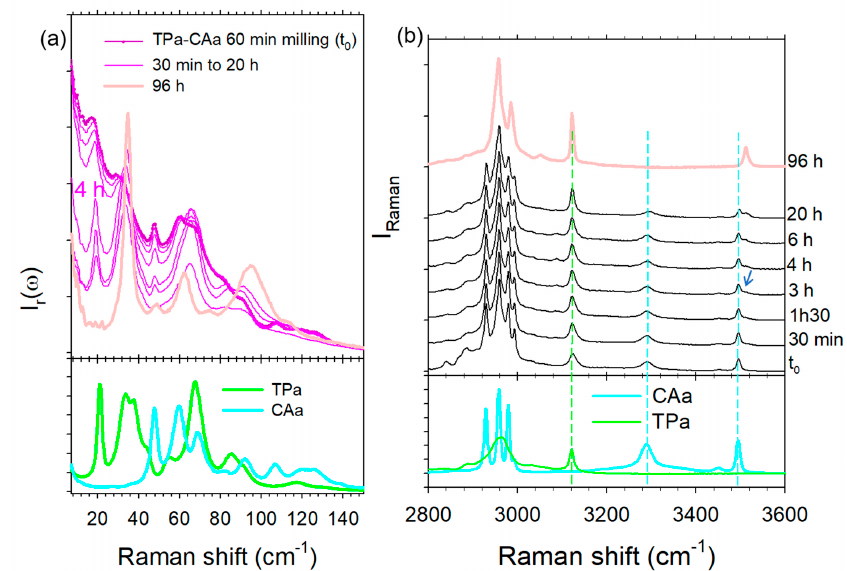
Figure 9. Spectra of (TPa, CAa) mixture co-milled at room temperature for 1 h, collected at various times after the milling procedure; ( a ) in the low-frequency region; ( b ) in the high-frequency region; spectra are compared with those of the anhydrous reactants (bottom graph); spectra were taken and plotted at same times in the low- and high-frequency regions . Raman investigations were simultaneously carried out in the high frequency region to better understand the mechanism of co-crystal formation. Spectra were plotted in Fig- ure 9b at various times until 20 h of transformation, the complete monitoring of the